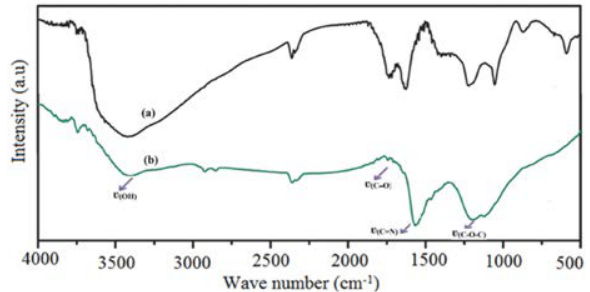
Figure 3. FTIR spectra of (a) GO (b) NG